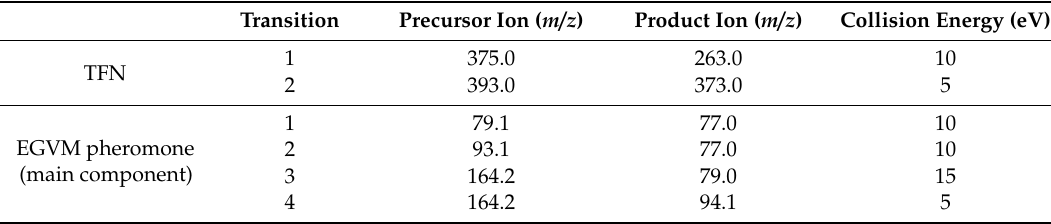
Table 1. Optimum values of the MS / MS parameters for each target